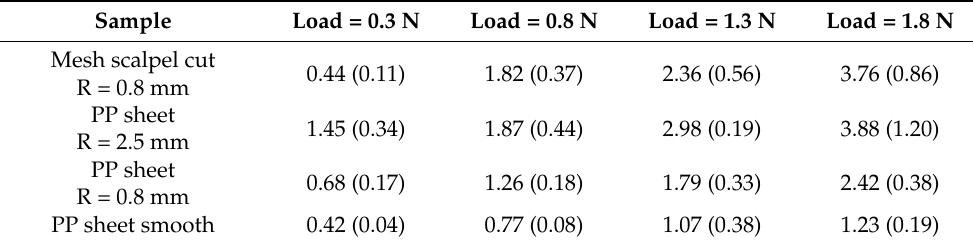
Table 3. Erosion rate (in mm/m) for tests conducted with a stroke length of 2 mm. Averages from at least 5 results per group: standard deviation in